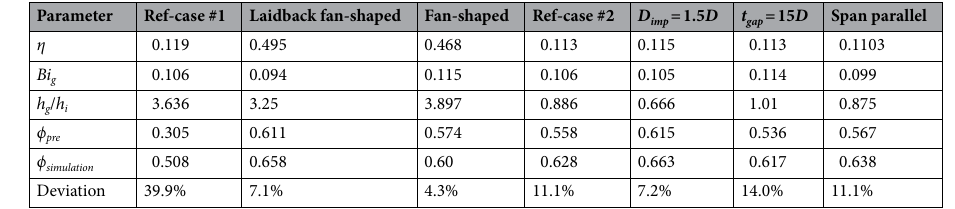
Table 7. Validation of one-dimensional conjugate heat transfer